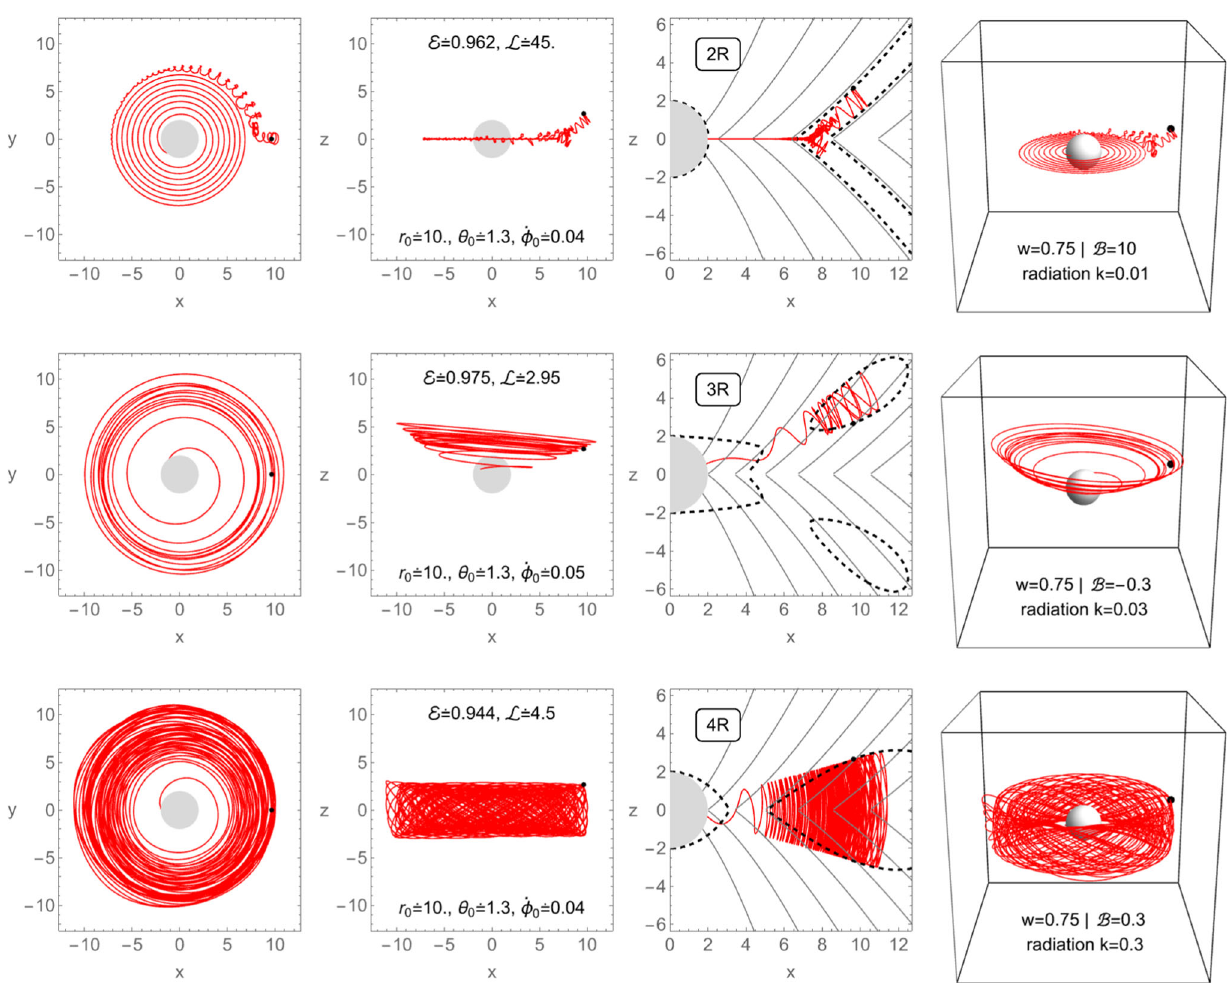
Fig. 8 Influence of RR on charged particle dynamics in parabolic ( w = 0 . 75) magnetosphere of BH. The initial conditions for parti- cle dynamics are the same as in Figs. 6 and 7. The radiation parameter k has been chosen unrealistically large in order to clearly demonstrate the